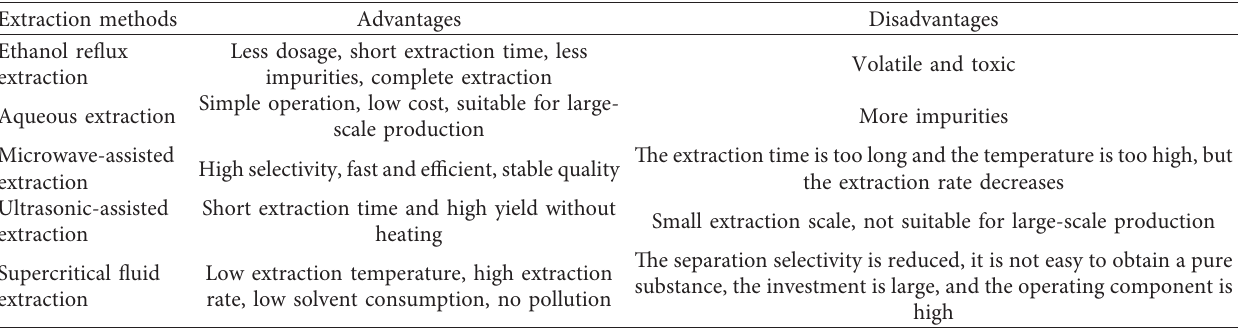
Figure 1: Different steps that may be involved in the preparation of flavonoids of corn silk. Table 2: The advantages and disadvantages of various extraction